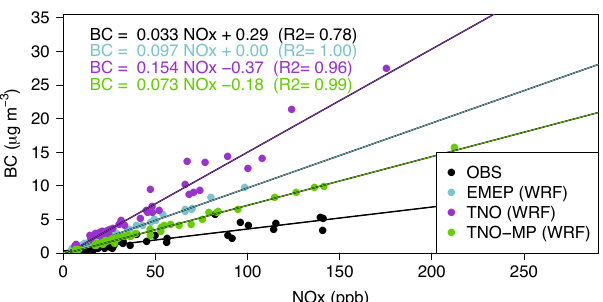
Figure 4. Observed and simulated BC vs. NO x concentrations at LHVP between 05:00 and 08:00UTC considering July flight days, and linear fits (lines). Only simulations with WRF meteorological data are reported